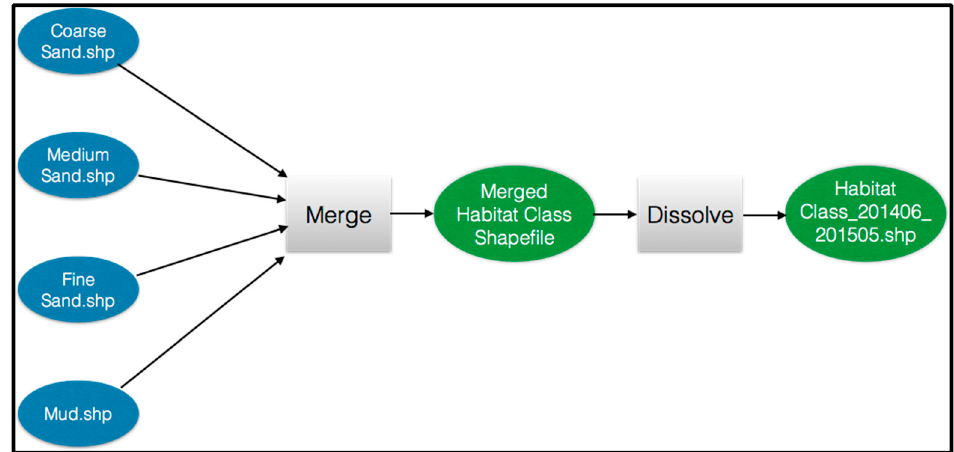
Figure 5. Flow-chart of data processing steps for manually segmented side-scan sonar-sediment classification into a habitat map for Assateague Island National Seashore, developed by the University of Delaware